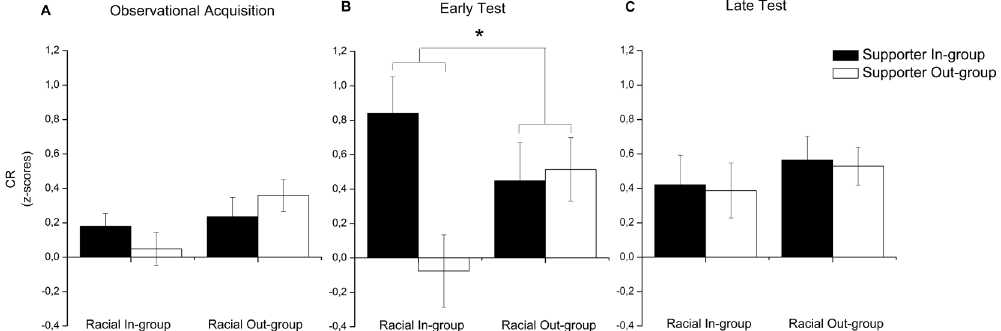
Figure 1. Mean CR (CS + > CS − ) across the experiments displayed for the Racial In-group and Racial Out- group separately as a function of Supporter group membership. ( A ) During observational acquisition SCRs to the CS + were overall higher than to the CS − in the absence of significant group differences. ( B ) During the early stage of the direct test, supporter group membership significantly modulated CRs but only when fear was transmitted from a racial in-group demonstrator ( C ). During the late stage of the direct test, there were no between group differences left. Errors bars denote standard error of the mean (SEM). * p <